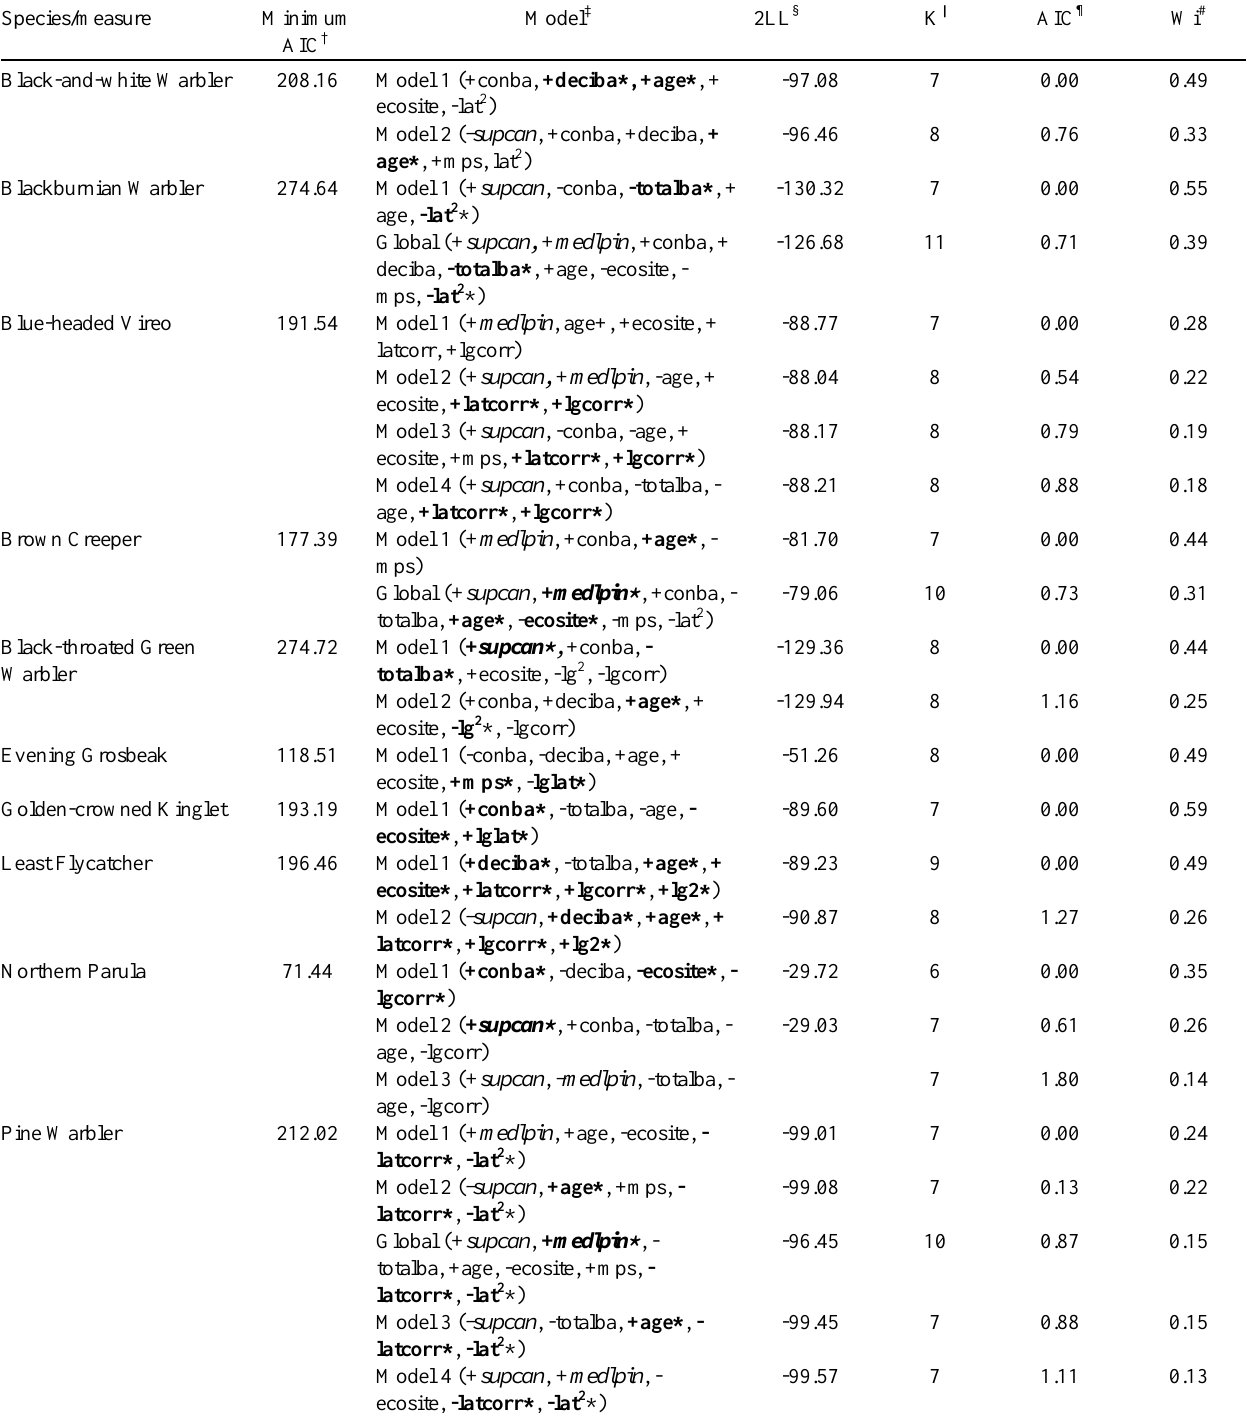
Table 2 . Model selection results for old-growth-pine-associated bird species. (See Table 1 for predictor variable acronyms). Pine variables are in italics. Significant (P < 0.05) variables are in bold with asterisks.